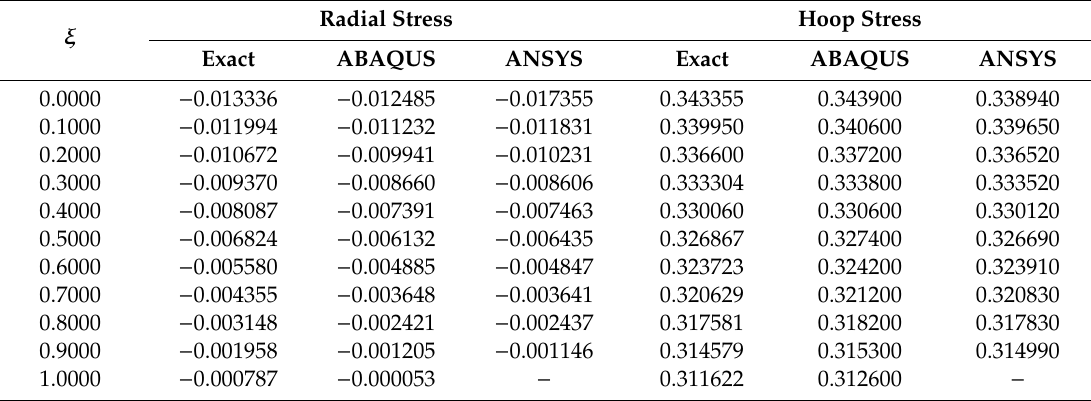
Table 5. Stress comparison of the balloon (MPa).